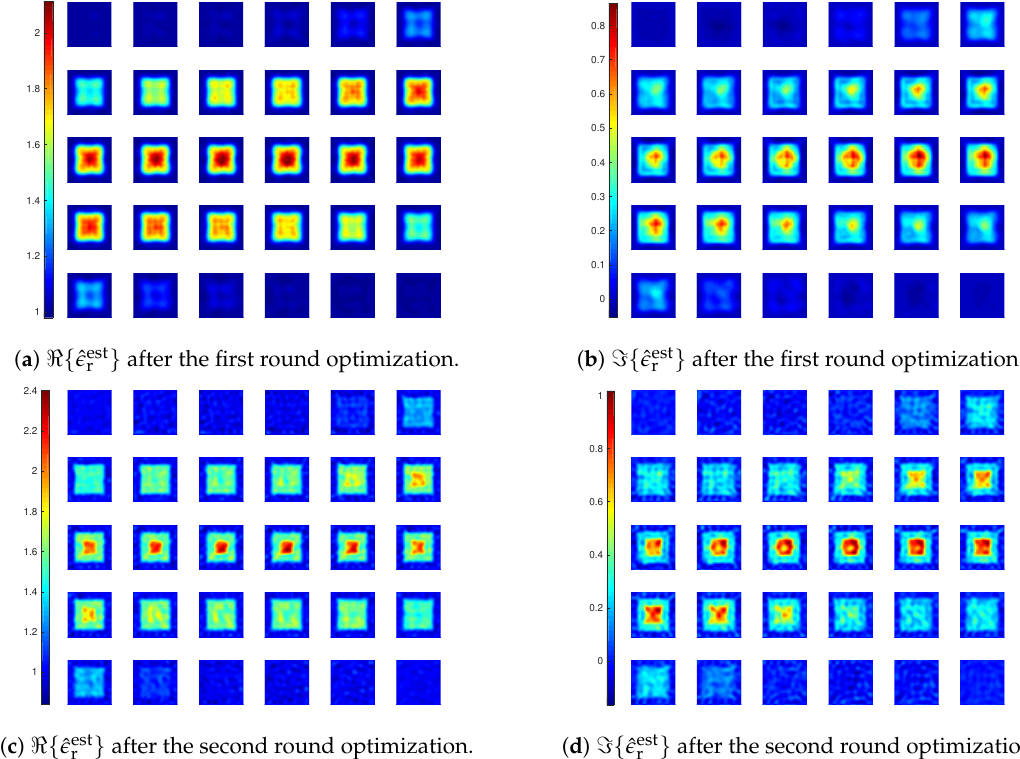
Figure 5. Reconstruction results of inversions with CIE-I. In the four subfigures, the 30 slices of DoI with each at z = z q plane, where z q , q = 1, . . . ,30, are the grid points along z -direction, and z p < z q if p < q . The displaying sequence is with the convention of left to right, and top to down. For instance, the top left corner one is with z 1 , and the top row second column one is with z 2 . The same applies